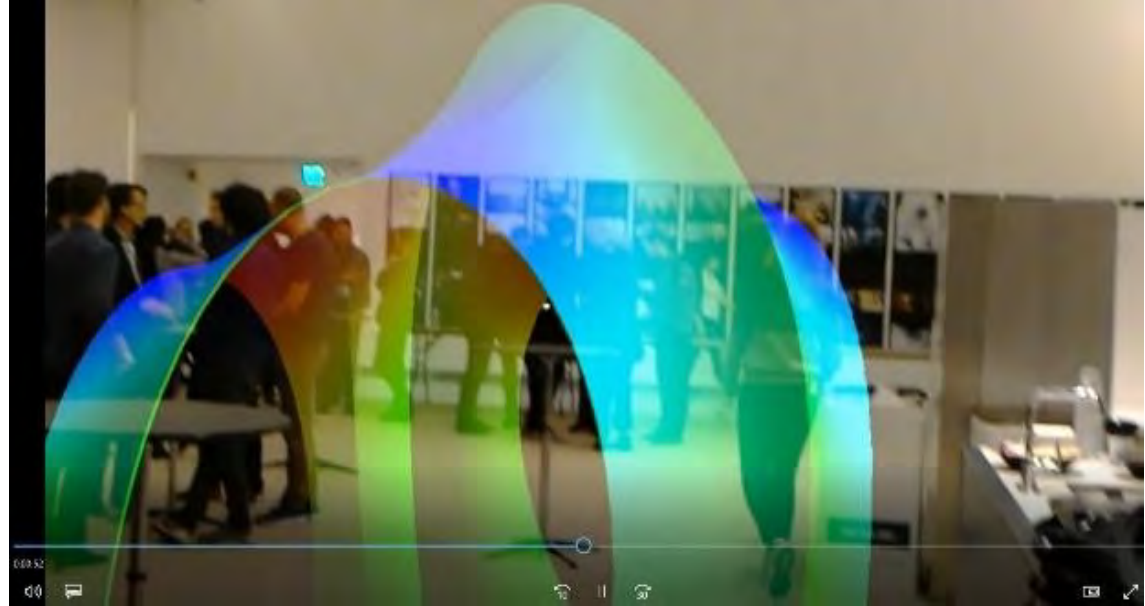
Figure 14. Mixed Reality Specialist Cameron Newnham (RMIT Australia) performing a full-scale visualization test ofan earthen shell using Holo